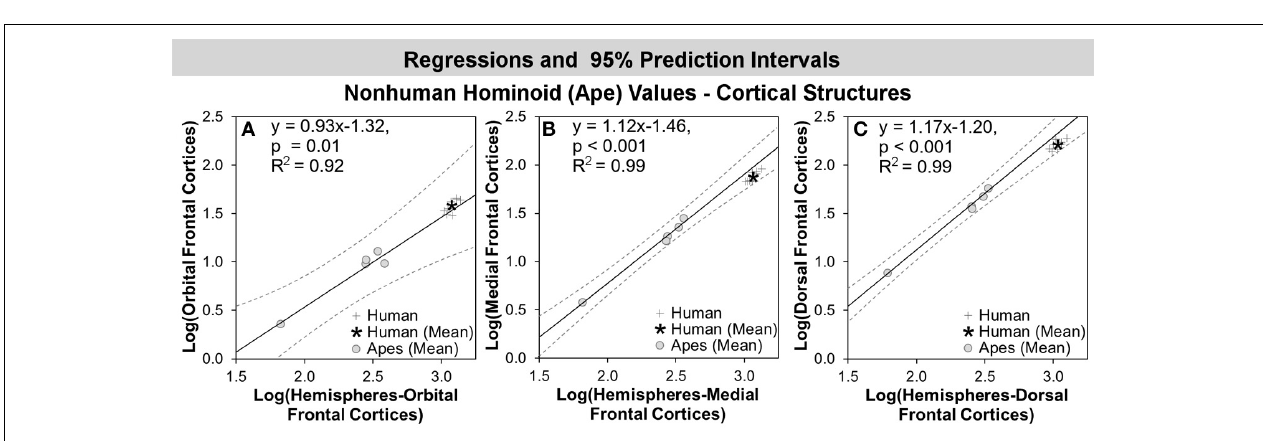
FIGURE 6 | Log-log regressions and 95% prediction intervals (dashed lines) of species average volumes (cc) for select structures in the anthropoid dataset, which reached significance or fell in the upper